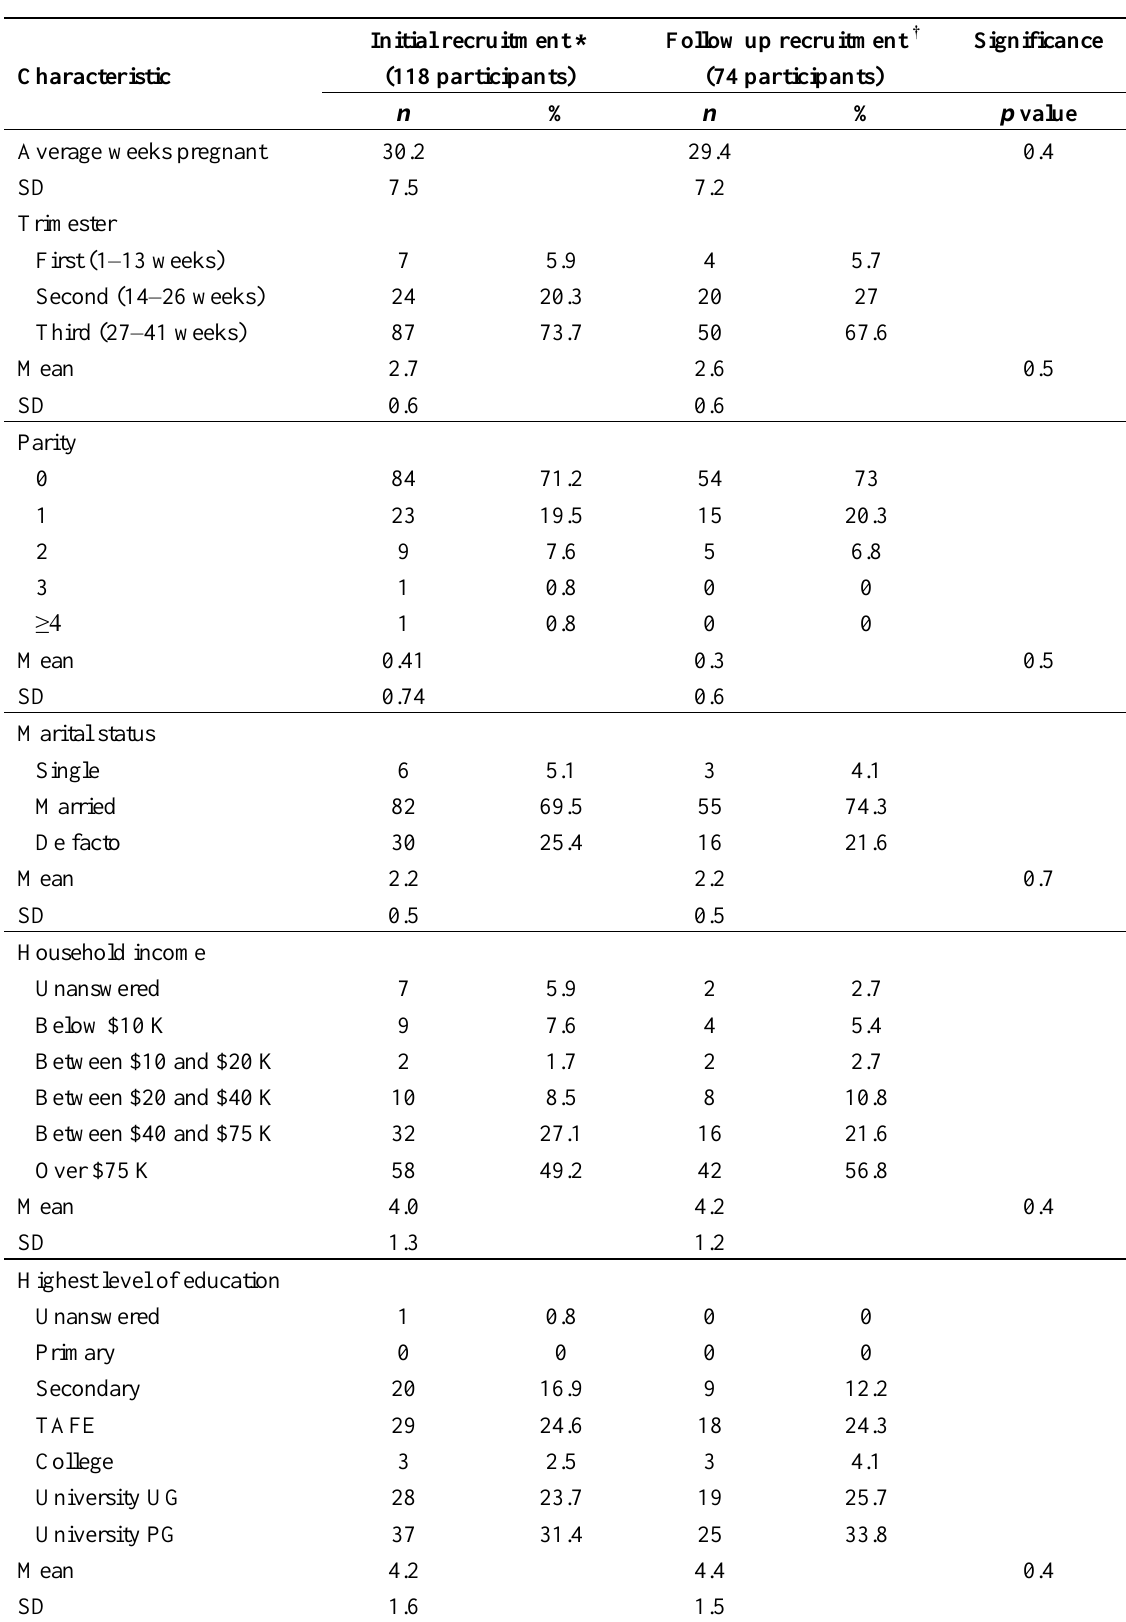
Table 1. Characteristics of participants in initial recruitment and follow up recruitment.